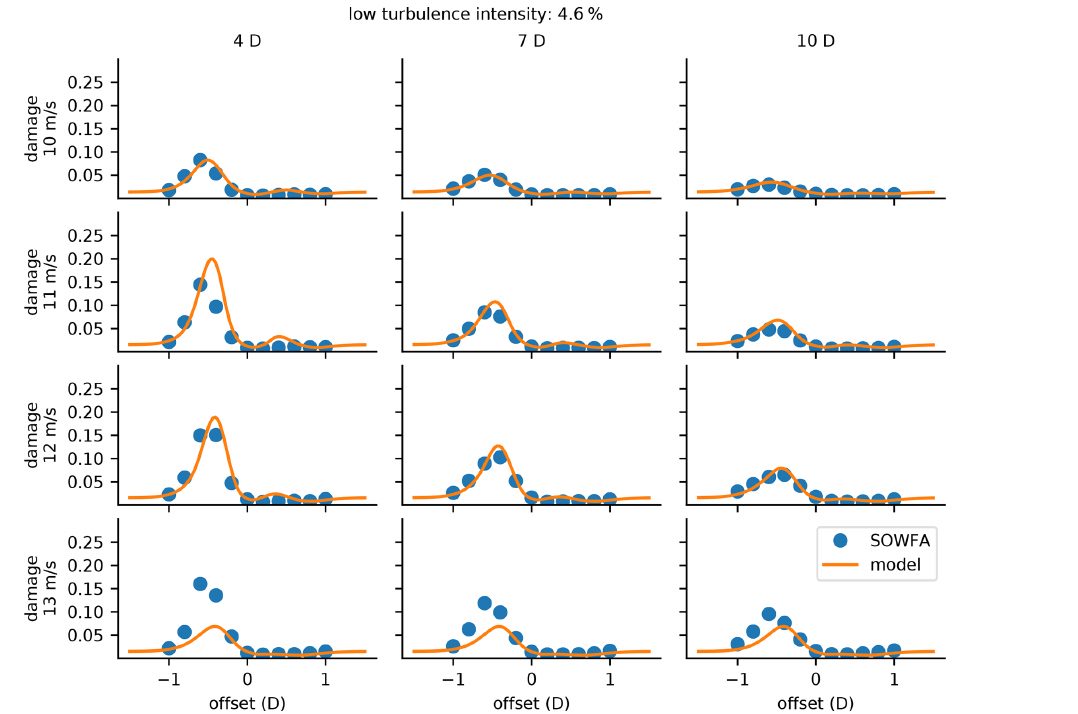
Figure 10. Comparison of our presented damage model to the lifetime damage predicted by the loads from the SOWFA and OpenFAST data. This figure is for a low freestream turbulence intensity of 4.6%. From top to bottom, each row represents different freestream wind speeds of 10, 11, 12, and 13ms − 1 . From left to right, each column represents different distances from the upstream turbine of 4, 7, and 10 D